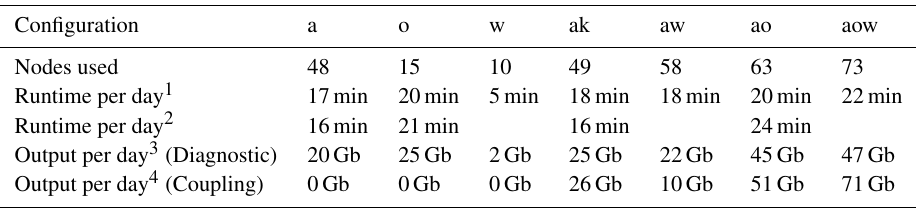
Figure 10. 7d precipitation accumulation during Titli case study over Bay of Bengal sub-domain region (a) observed by GPM (NASA Global Precipitation Measurement) and simulated by (b) ATMfix_FH, (c) ATM_FH, (d) KPP_FH, (e) AO_FH and (f) AOW_FH. All simulated data are interpolated to the GPM resolution prior to computing accumulations. See Fig. S3 for corresponding figure for simulations without frictional heating enabled. Table 9. Summary of the typical computational resources required to run RCS-IND1 experiments, runtimes and output data volumes for completing a day simulation. Run durations quoted in row 1 were completed using the Met Office Cray XC40, and those completed in row labelled 2 were completed using the NCMRWF high-performance computing server Mihir Cray XC40. Two output data volume rows are given. The diagnostic output (row 3 ) shows output data size saved to disk for daily restart and model variables of interest to enable analysis. Note number and type of output diagnostics are dependent on user specifications, but values are indicative of default RCS-IND1 configurations and data volumes typically archived. The coupling output (row 4 ) shows the volume of data written to disk to support coupling exchanges (computed as difference between total output volume quoted in daily log file and the diagnostic output size on disk). Note that the data volumes required for coupling are less user specific, and these data are not relevant for archiving but will scale with choice of coupling frequency. All values reflect configurations without